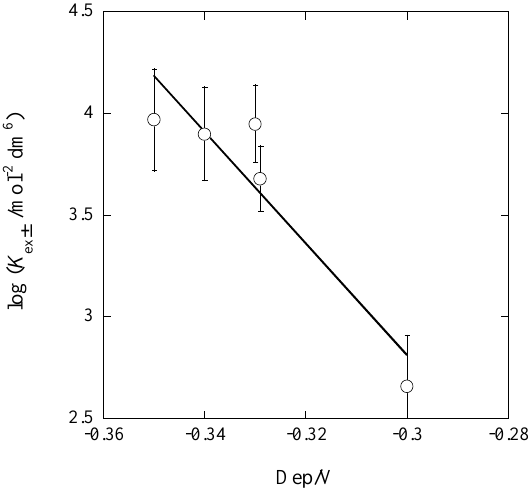
Figure 4. Plot of log K ex ± versus dep for the Pb(II) extraction with Cd(NO 3 ) 2 and B18C6 into Bz. The line corresponds to Equation (11a).